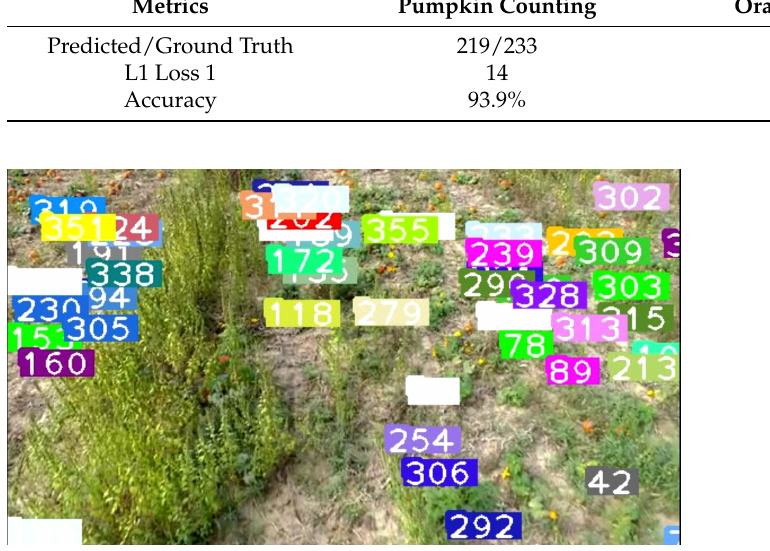
Figure 12. A frame taken from the video showing the view of the pumpkins and all of the current detections, the numbers denote the track